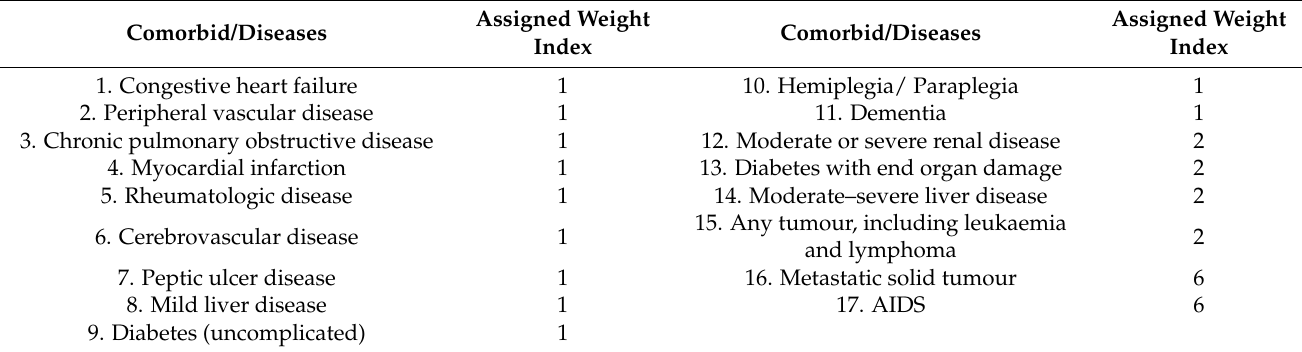
Comorbid/Diseases